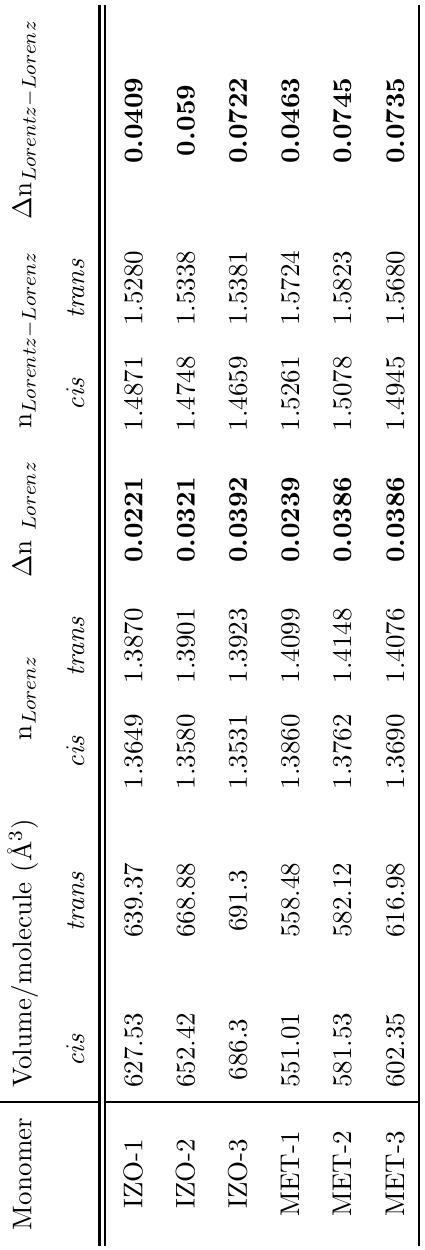
Table 3 Refractive indices and refractive index changes calculated utilizing the two models Lorenz and